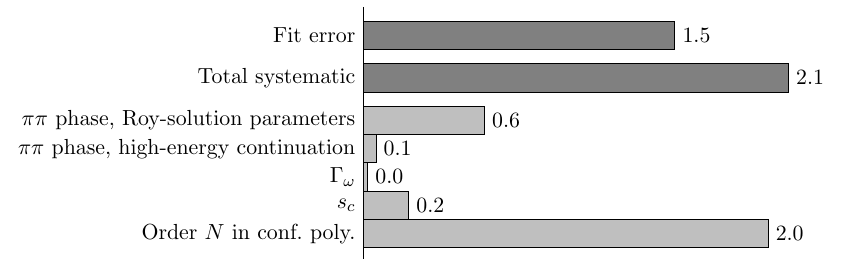
Figure 15. Contributions to the uncertainty of a (cid:25)(cid:25) (cid:12)t to SND, CMD-2, BaBar, KLOE 00 , and